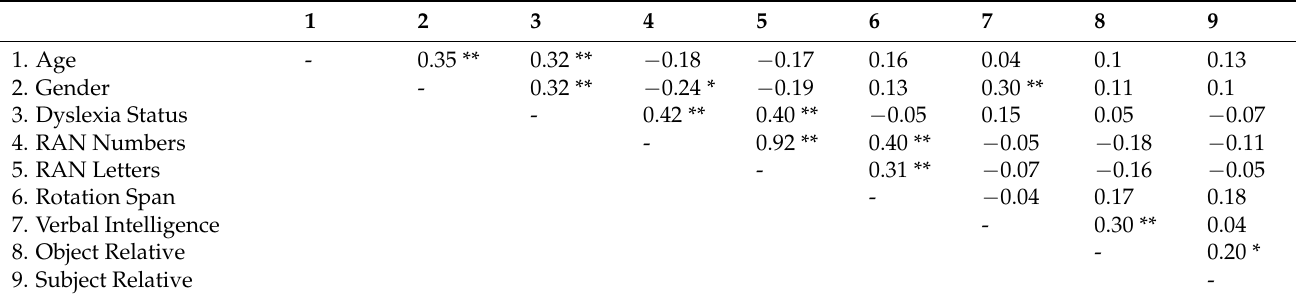
Table 3. Correlations between demographics, individual difference variables and